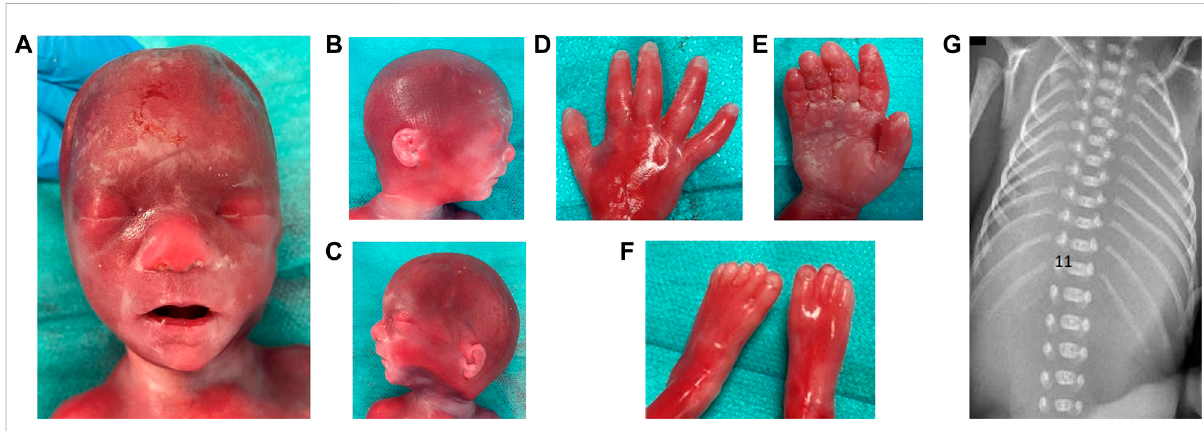
FIGURE 2 Dysmorphological examination of fetus of Case 1 is shown in (A) facial view: fl at nasal bridge, prominent philtrum; (B) facial right; (C) facial left pro fi le: ear asymmetry, mildly low-set ears, right lobar hypoplasia, mild retrognathia; (D) dorsal face of right hand: clinodactyly of 5th fi nger; (E) palmar face of right hand; (F) feet; (G) 11 bilateral and complete rib pairs and costal sketch of the twelfth vertebra on the